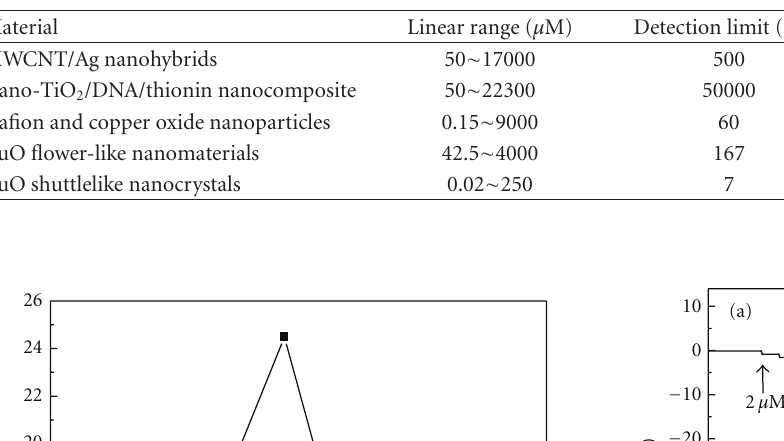
Table 1: Performance comparison of the H 2 O 2 sensors based on di ff erent-materials-modified electrodes.